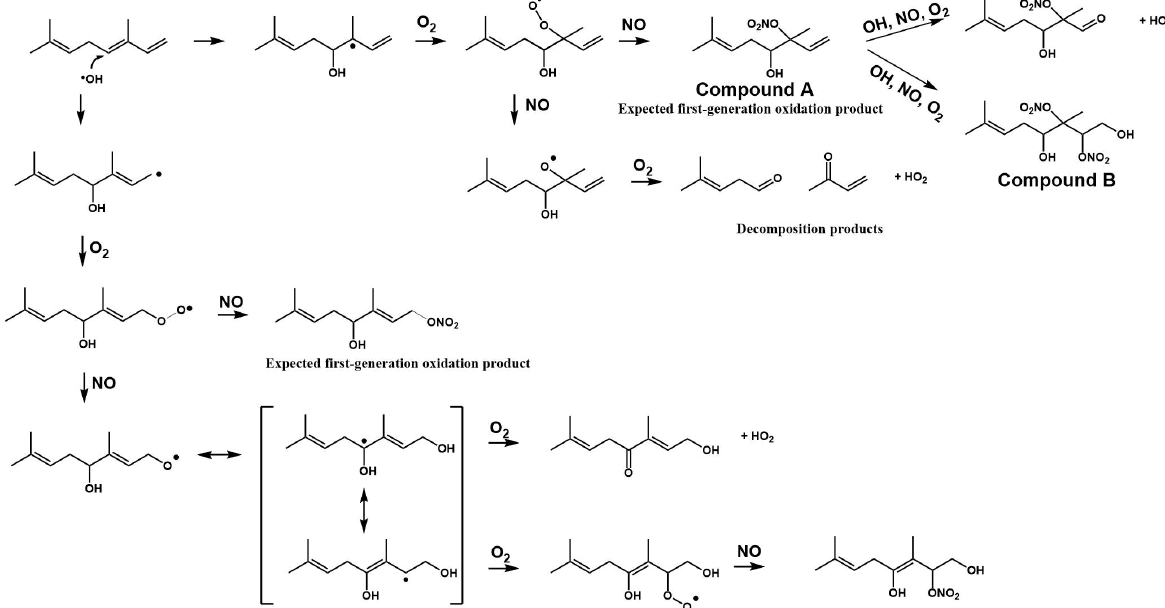
Figure 2. Example reaction pathways of the OH-initiated oxidation of β -ocimene in the presence of NO x .